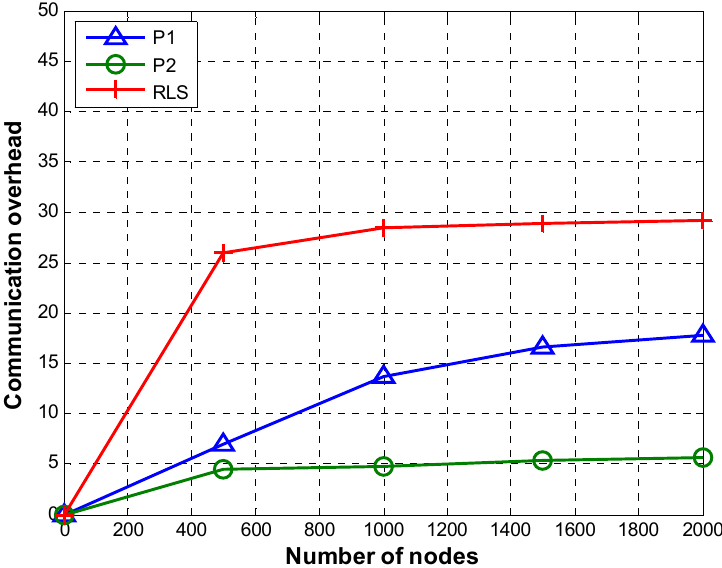
Figure 15. Communication overhead (sparsity).